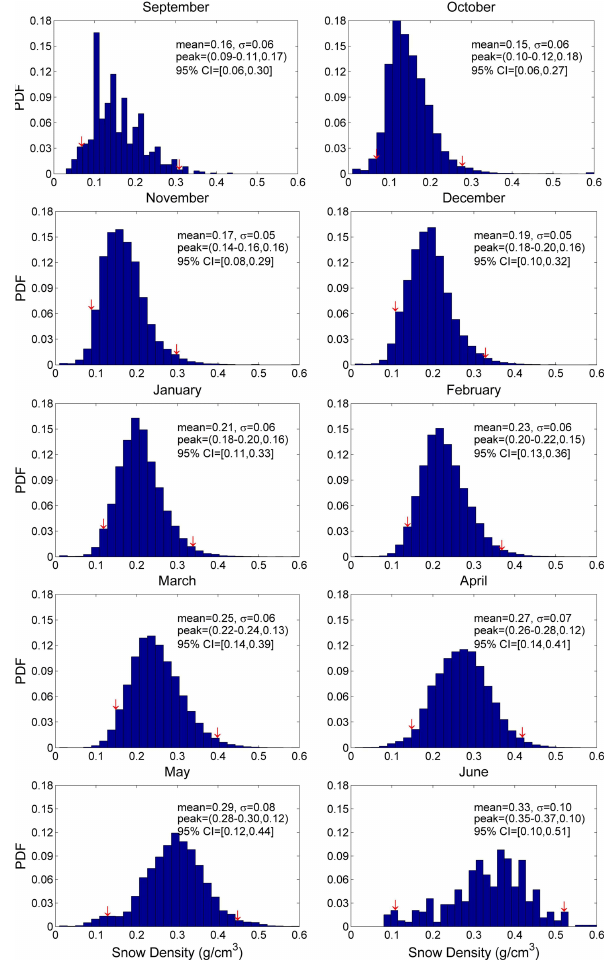
Fig. 12. PDF of monthly snow density. The bar is PDF of snow den- sity; the down arrows represent the bracket 2.5% and 97.5% spec- trum distribution of snow density. Mean and σ represent the cal- culated mean and standard deviation of all snow density (gcm − 3 ) , respectively. Peak stands for the peak PDF of snow density (right) and the corresponding snow density (left); 95% CI represents the range of snow density at 95% credibility interval; CI is the abbre- viation for “credibility